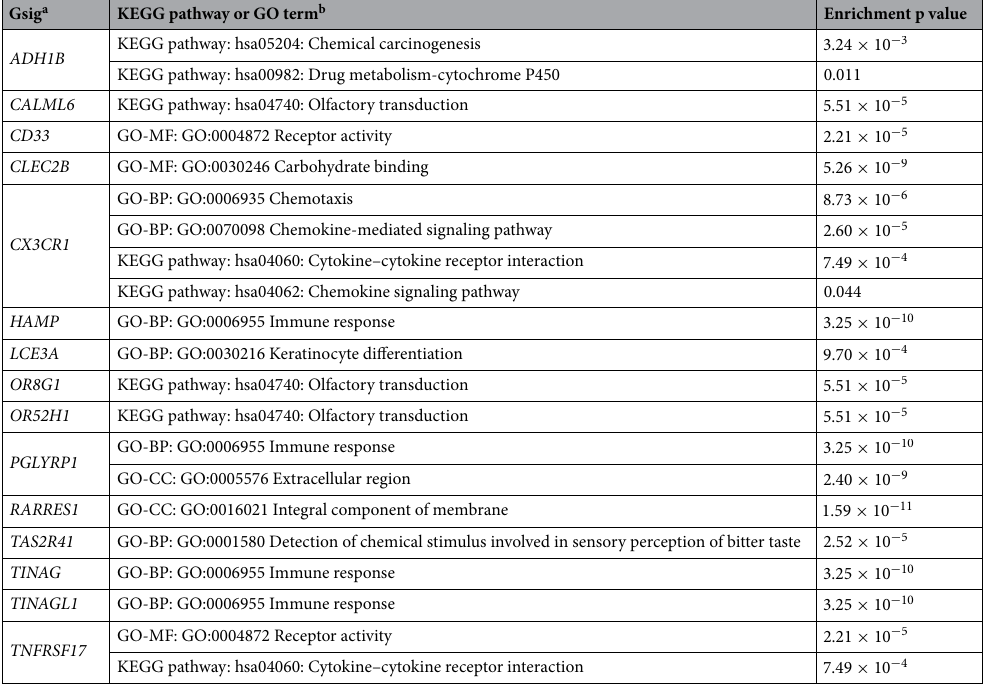
Table 6. Top significant KEGG pathways and GO terms enriched with Down syndrome specific genes. a Gsig: genes belonging to the gene signature. b For GO terms, it has three domains: Biological Process (BP), Cellular Component (CC), and Molecular Function